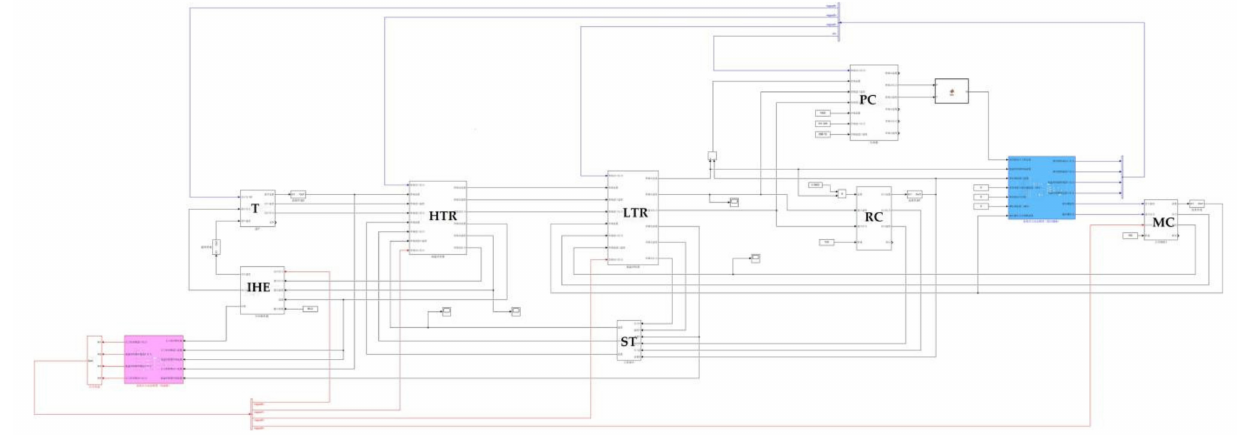
Figure 7. Simulink dynamic model diagram of the SCO 2 recompression